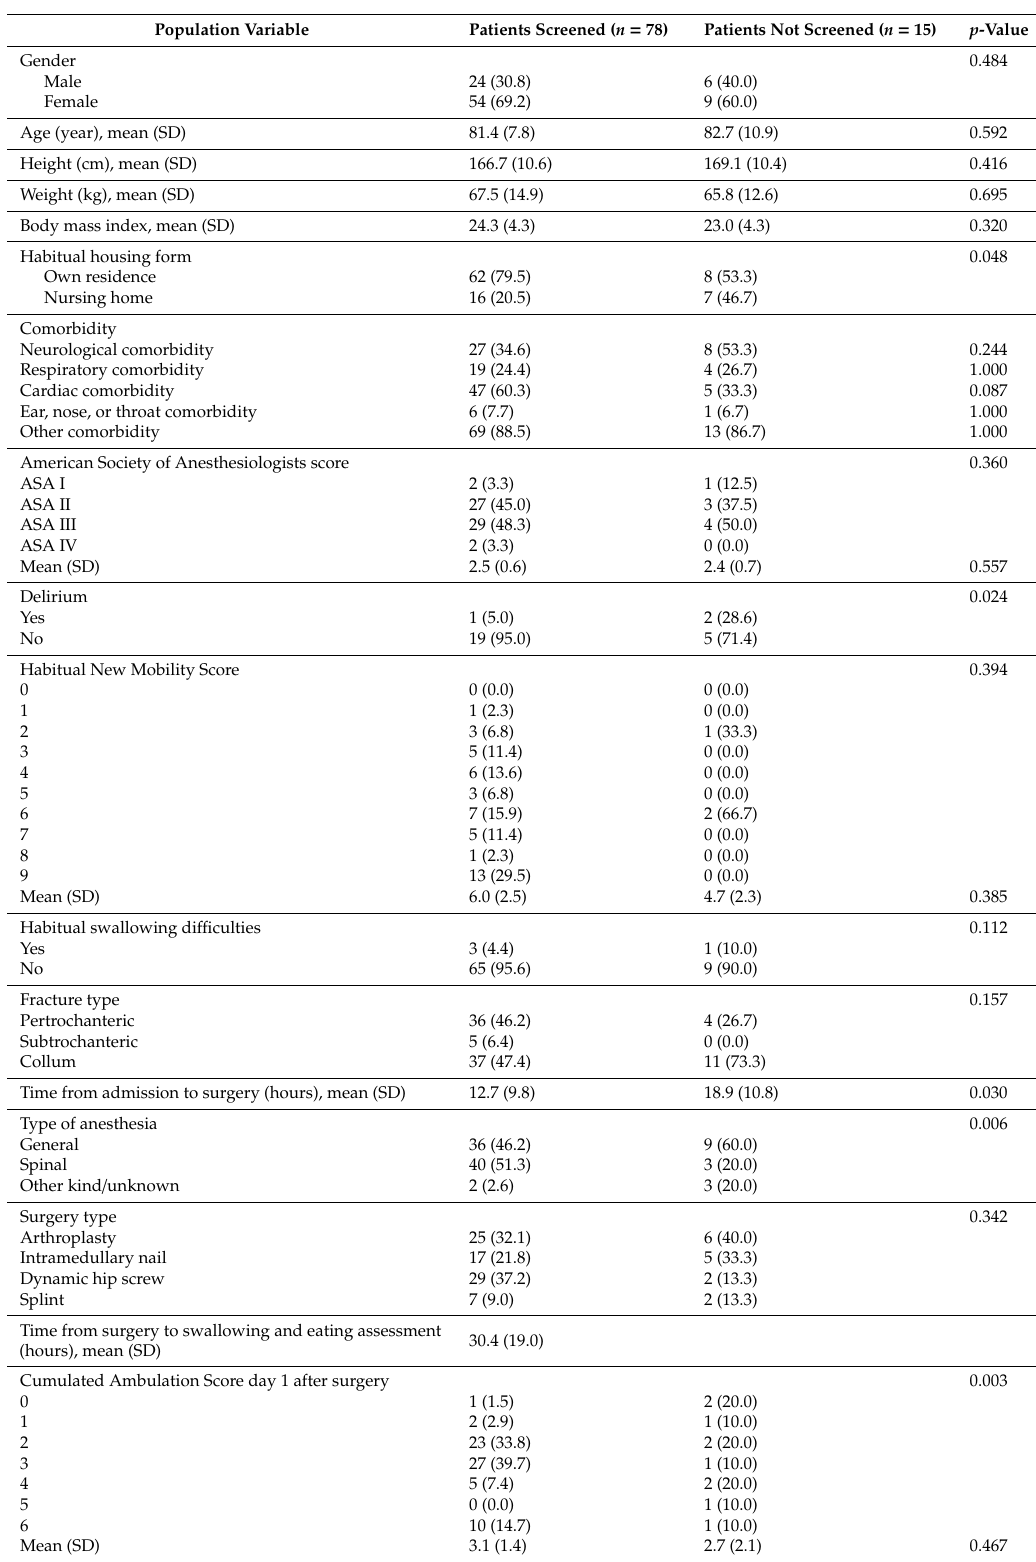
Table 1. Baseline demographics and clinical characteristics and comparison of these factors of patients screened and patients not screened for swallowing and eating di ffi